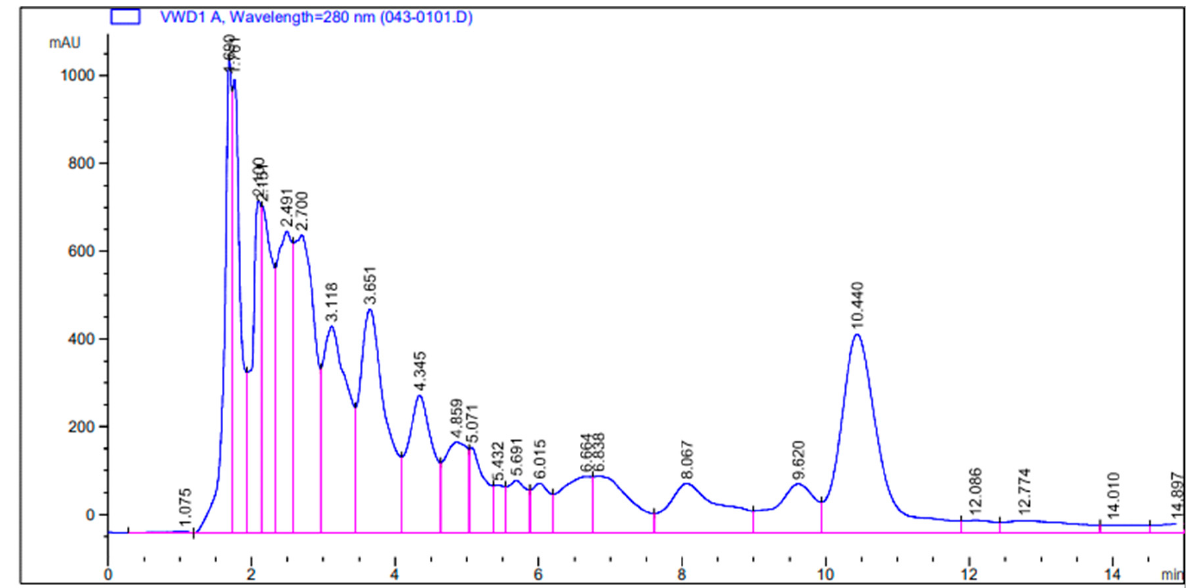
Figure 3. HPLC chromatograph of vanillin, quercetin, gallic acid, and caffeine from C. limon extract. The pink coloured lines represent the retention/peak values.